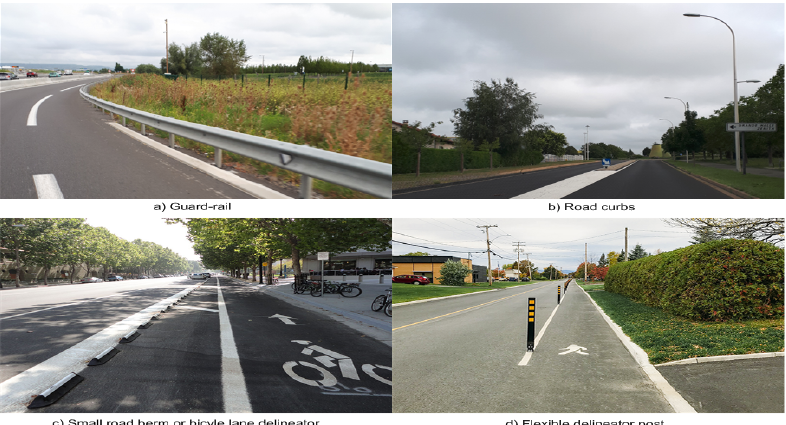
Figure 1. Road borders: ( a ) Guard rail on highway access road, ( b ) road curbs on urban environment, ( c ) small road berms used as bicycle lane delineators, and ( d ) multipurpose flexible delineator